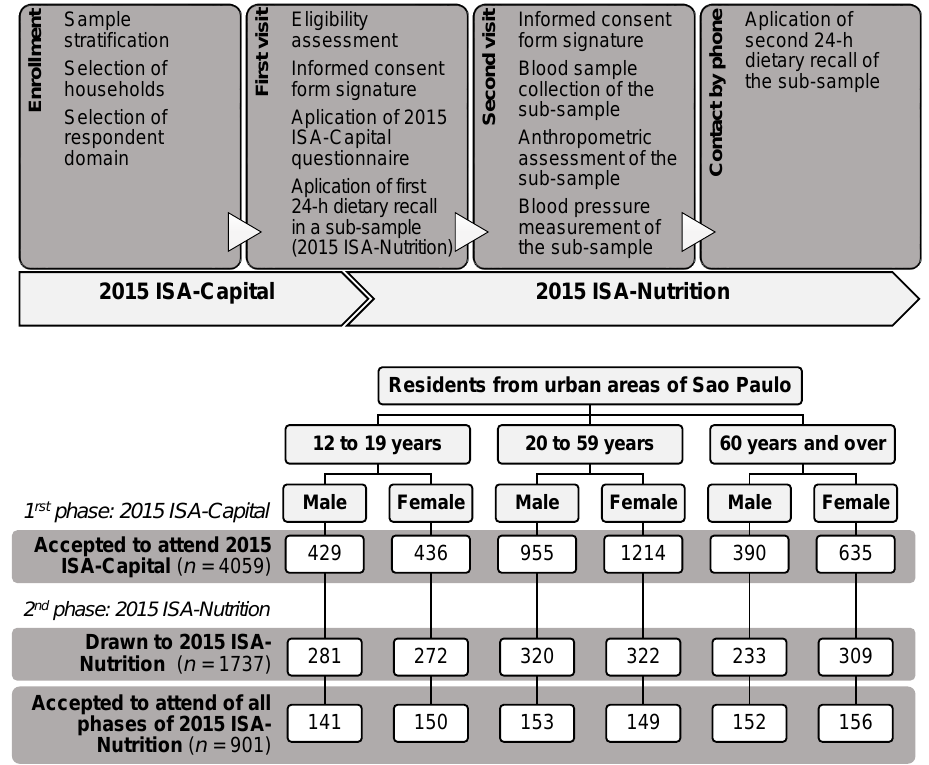
Figure 1. Study design and description of the sample number in the 2015 Health Survey of S ã o Paulo with Focus in Nutrition Study (2015 ISA-Nutrition). S ã o Paulo,